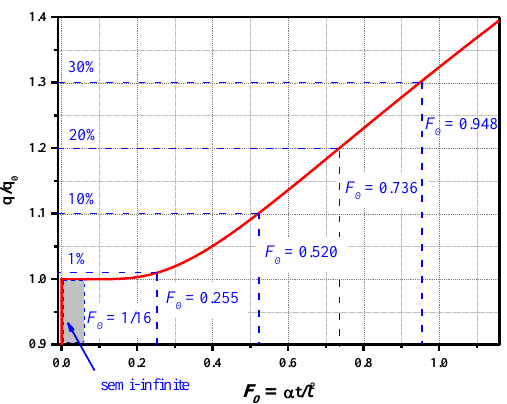
Figure 3. Thickness of the plate versus time for different Fourier numbers.